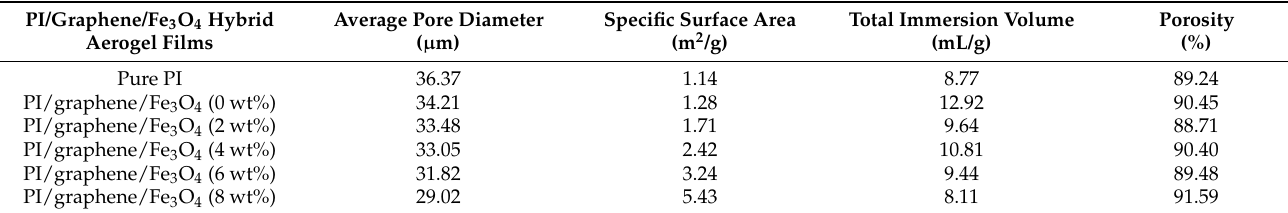
Figure 8. SEM images of ( a ) pure PI aerogel/PEG composite film and the PI/graphene/Fe 3 O 4 aerogel/PEG composite films with a graphene content of 5 wt% and different Fe 3 O 4 contents of ( b ) 0, ( c ) 2, ( d ) 4, ( e ) 6, and ( f ) 8 wt%. The chemical and crystalline structures of the PI/graphene/Fe 3 O 4 hybrid aerogel films were characterized with EDX, FTIR, and XRD using the hybrid aerogel film containing 5 wt% of graphene nanosheets and 6 wt% of Fe 3 O 4 nanoparticles as a representative. Figure